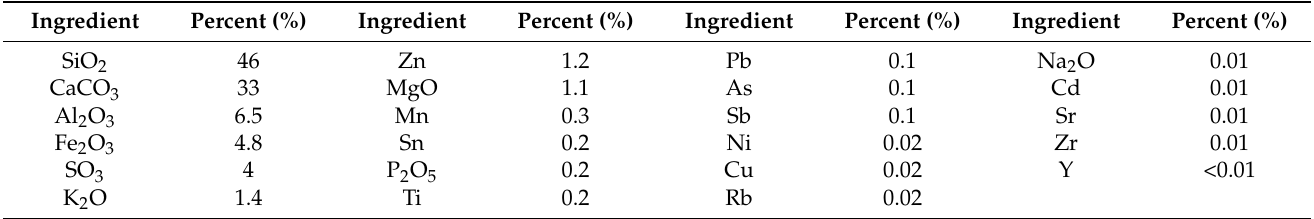
Table 1. The chemical composition of the test samples through semi-quantitative